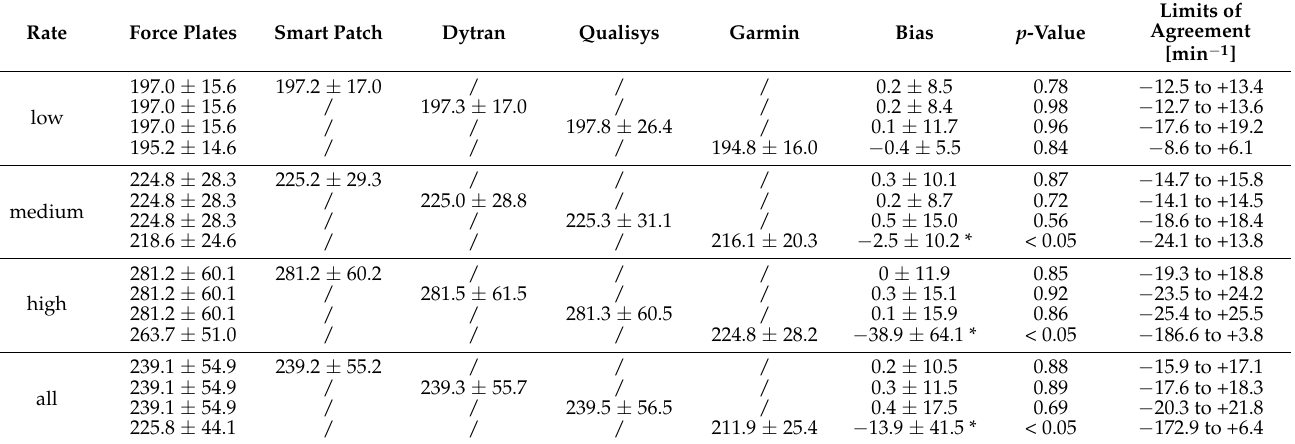
Table 1. Comparison of the rates of running in place (min − 1 , means ± SD) as determined with S2P bilateral force plates, the smart patch, Dytran accelerometers, the Qualisys motion capture system, and the Garmin Running Pod.